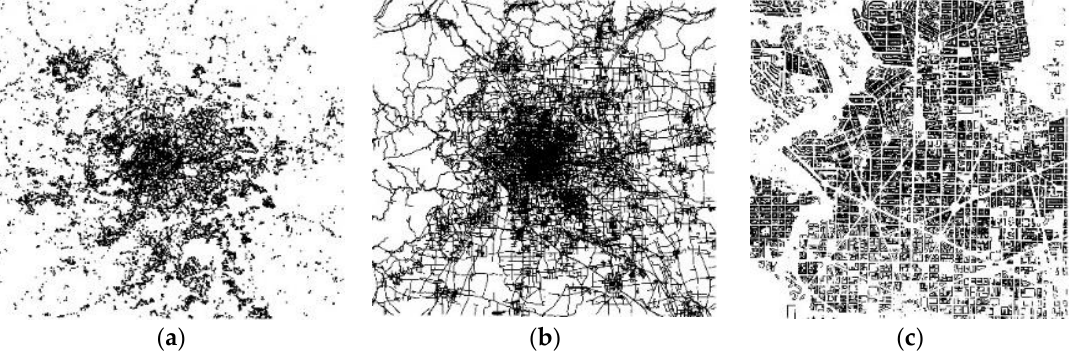
Table 3. Three experimental datasets.